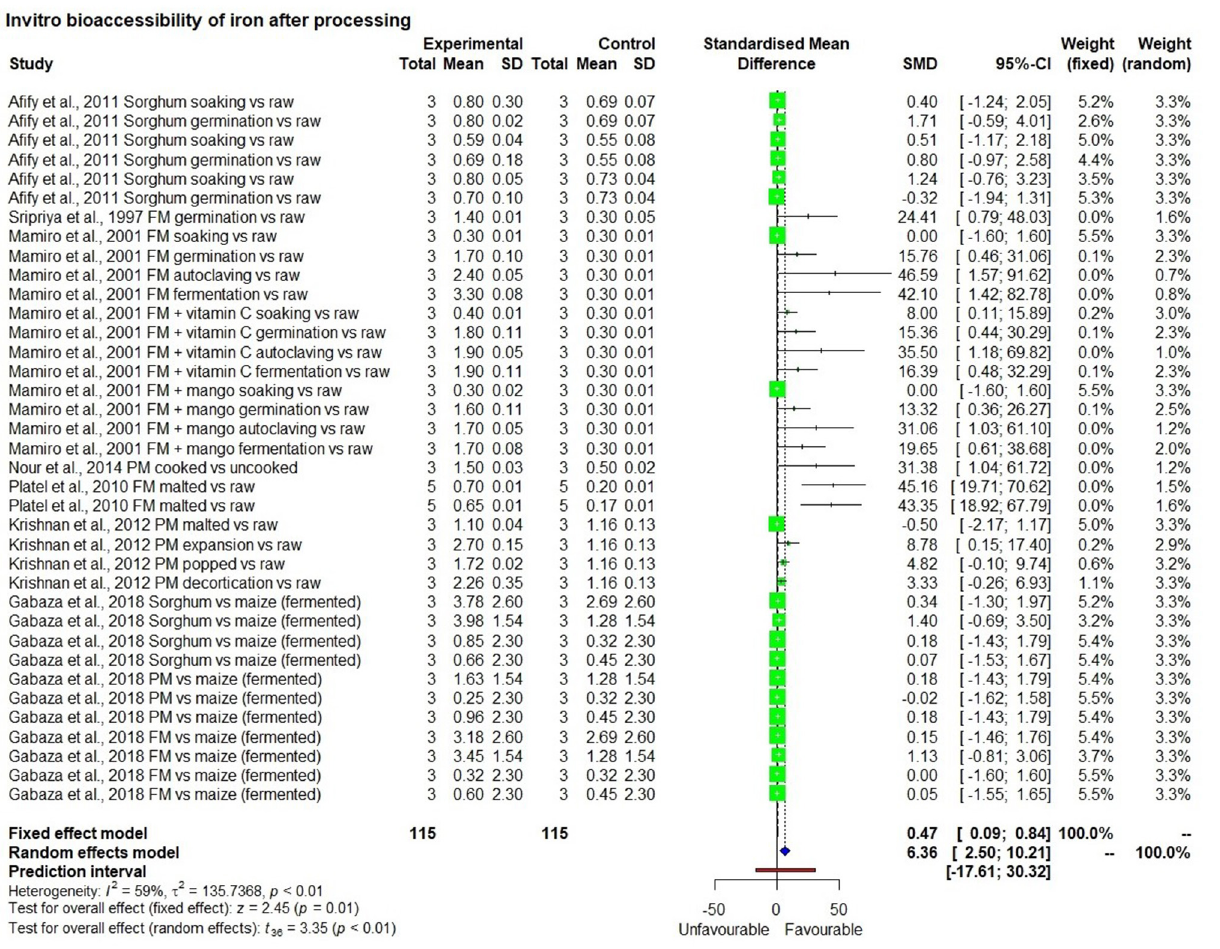
FIGURE 6 | In-vitro bioavailability of iron in millets after